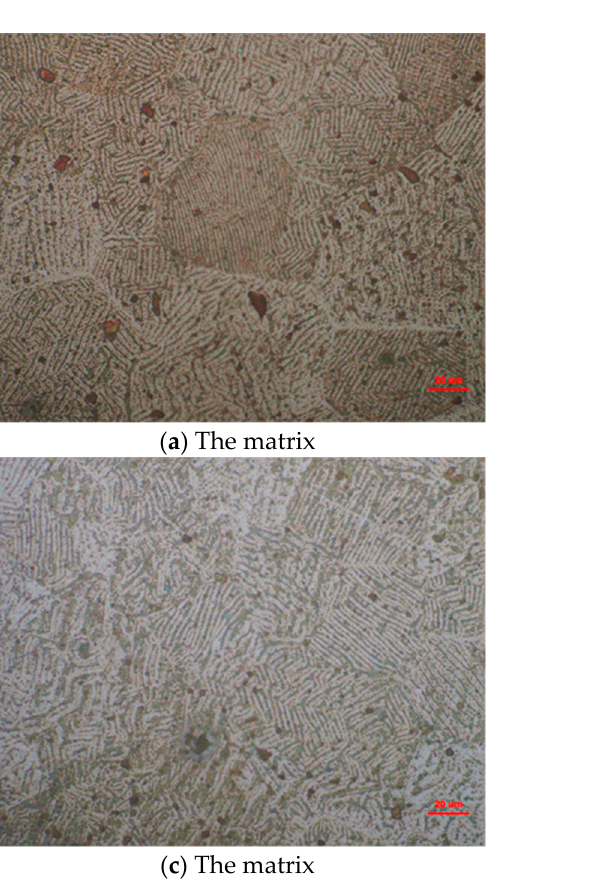
Figure 11. The magnetic domain structure near and away from the cut edge. ( a , b ) and ( c , d ) for 7.70-type and 7.80-type non-oriented electrical steel, respectively.